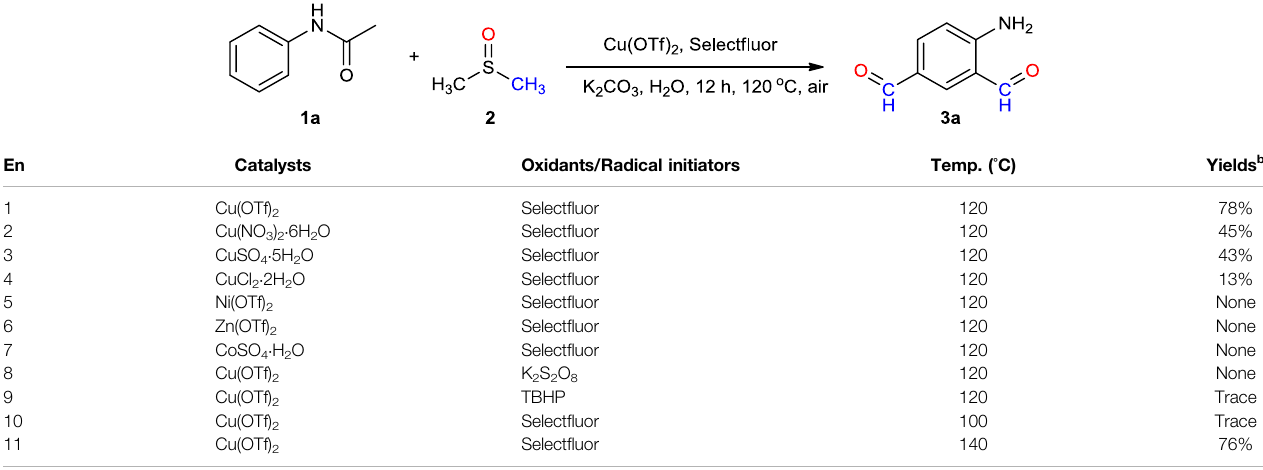
TABLE 1 | Optimization of the formation of 4-aminobenzene-1,3-dicarbaldehyde ( 3a ) a .